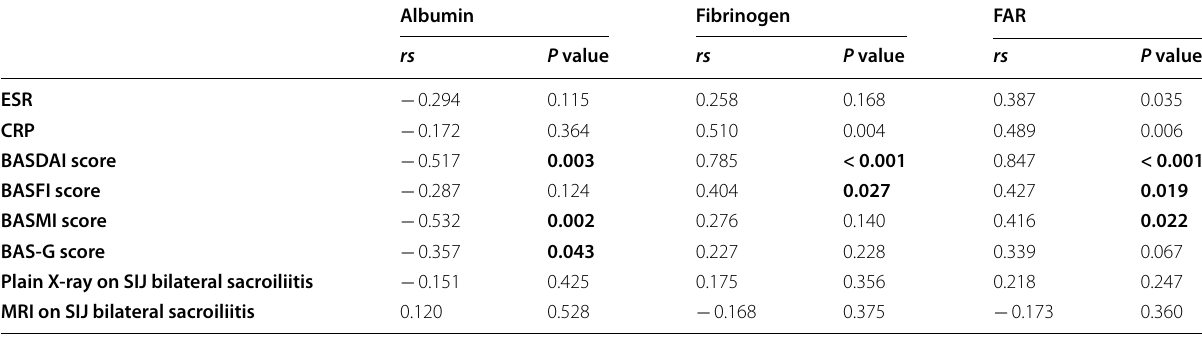
rs correlation coefficient, SIJ sacroiliac joint